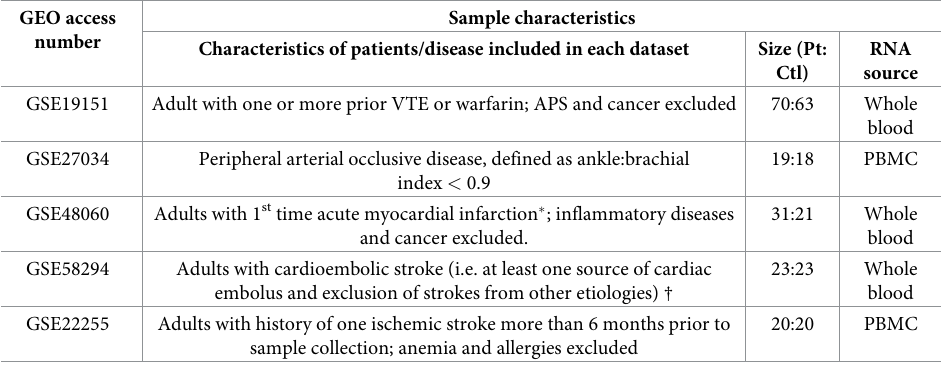
Table 1. Characteristics of individual studies included in our